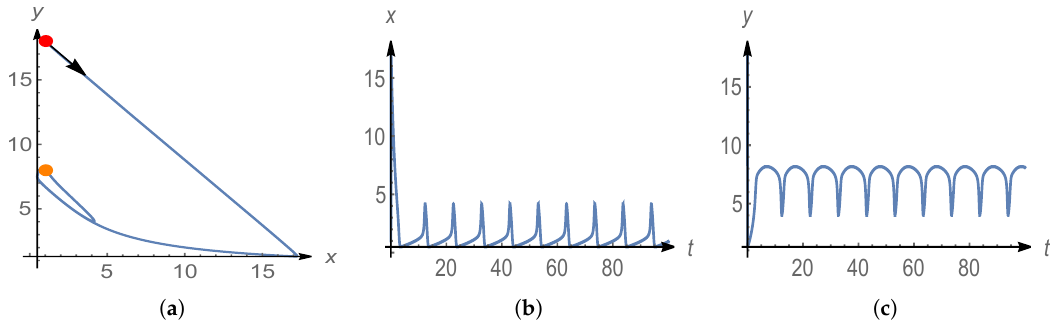
Figure 2. Model 1 with one stable limit cycle. The trajectory is going inward, approaching the limit cycle. The distance of the initial point from the singular point is d = 10.